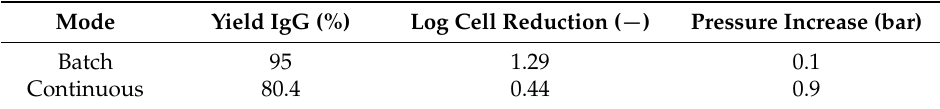
Figure 16. Settler volume as a function of residence time for different system scales obtained for the MAV ( left ) and simplified Henschke method ( right ). The dashed lines indicate the experimentally- tested scenarios (from top to bottom): 12.6 L, 0.75 L, and 0.175 L settler volumes for 160 L, 10 L, and 4 L ATPS volumes. 4. Materials and Methods 4.1. Aqueous Two-Phase Systems In this work, four ATPS are considered. The components of the individual systems with their approximate phase splits are listed in Table 6.